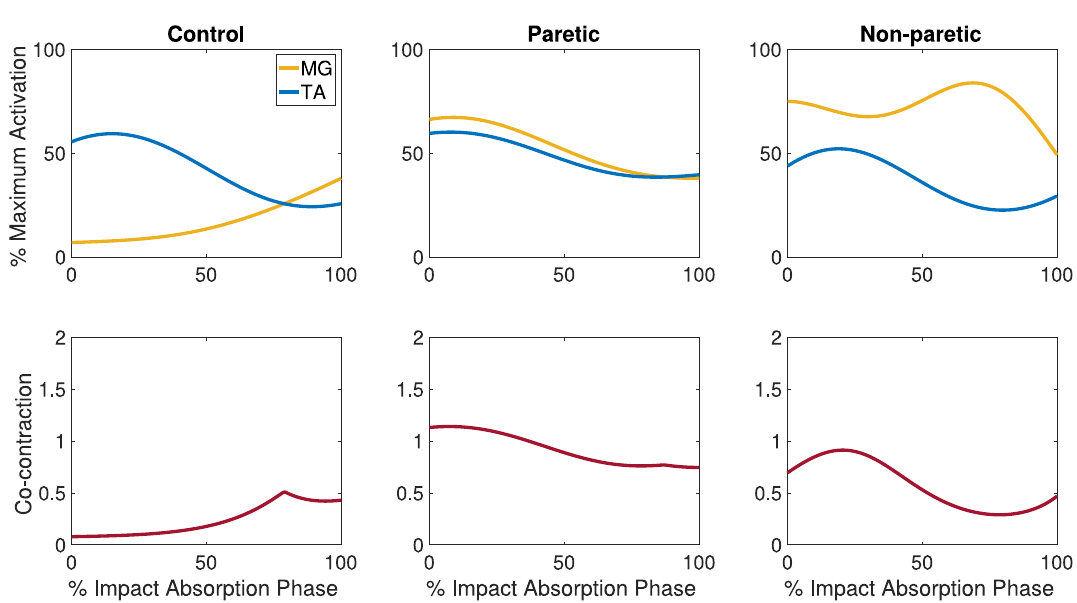
Figure 3. Representative trial of ankle muscle activation in the paretic and non-paretic side post-stroke and control during the impact absorption phase. The normalized EMG signals are shown in the upper panels, and the lower panels represent co-contraction duration during the impact absorption phase. MG medial gastrocnemius, TA tibialis anterior. Co-contraction was calculated with Eq. (1) between MG and